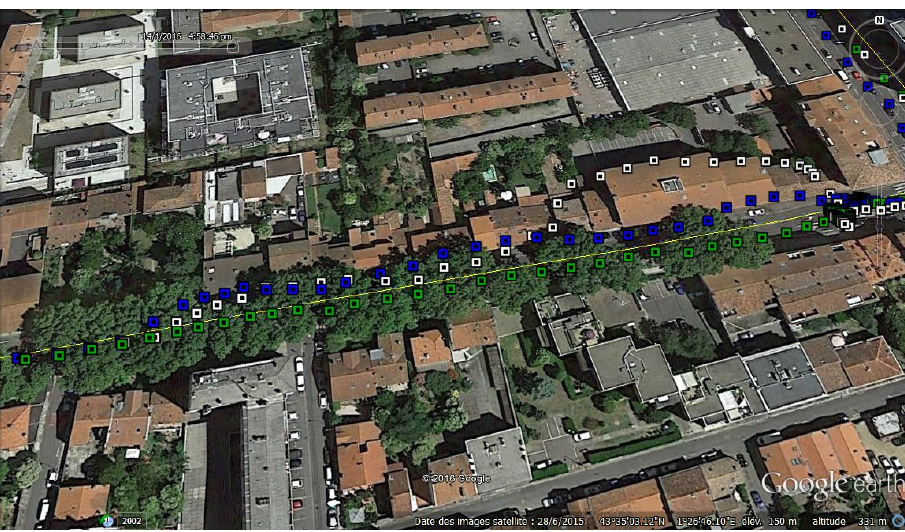
Figure 4. Comparison of PVT horizontal error given by different discriminators.